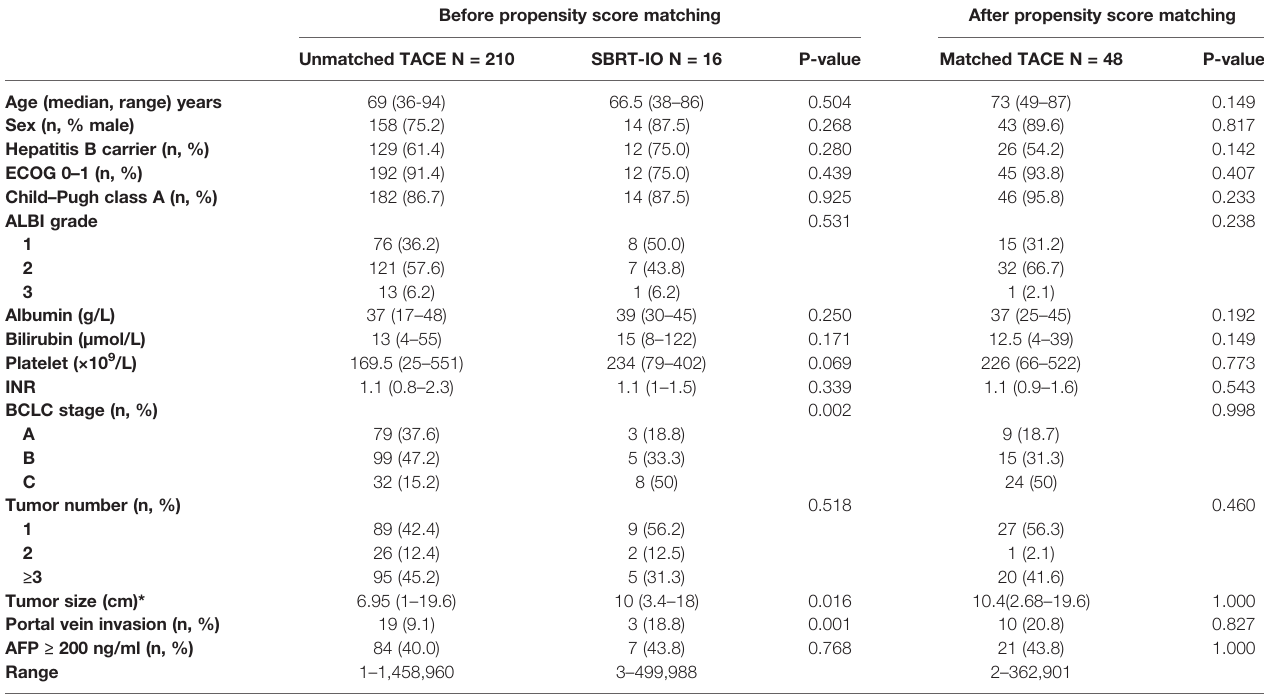
TABLE 1 | Baseline demographics and tumour characteristics of all patients. Before propensity score matching After propensity score